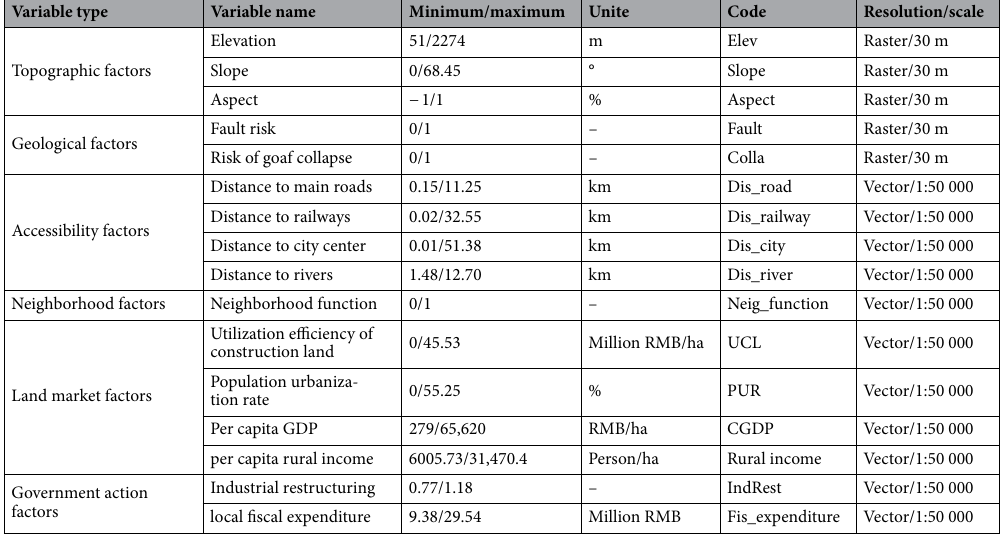
Table 1. Description of driving factors.